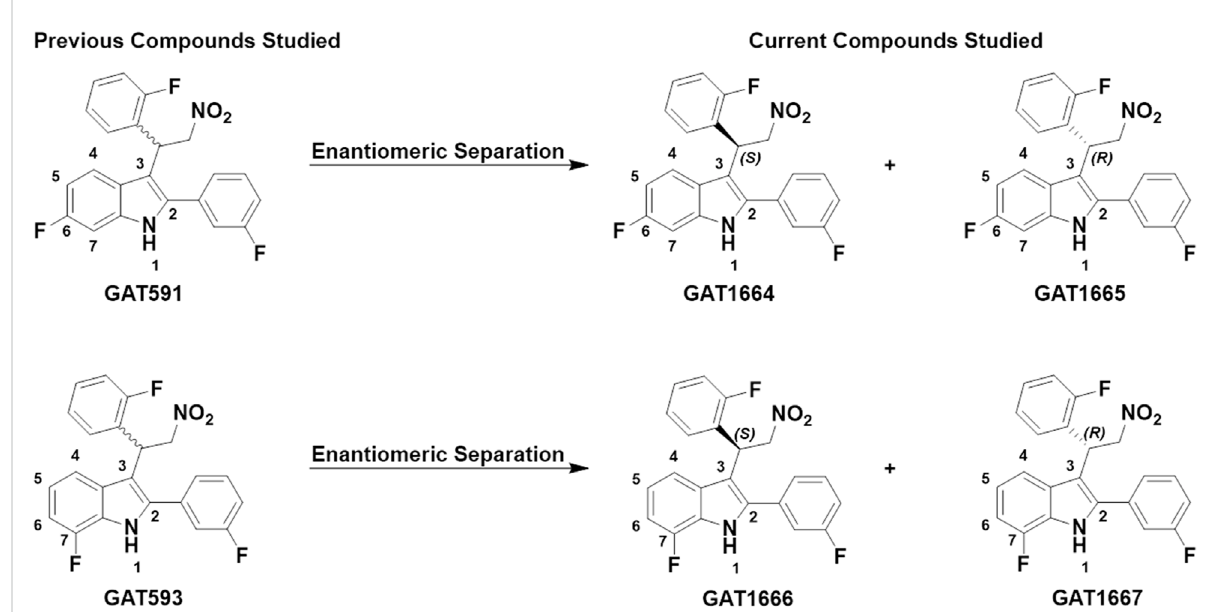
FIGURE 1 GAT591 previously studied was separated out into its respective enantiomers (GAT1664 and GAT1665) and GAT593 was separated out into its respective enantiomers (GAT1666 and GAT1667). The difference between GAT1664 and GAT1665 vs. GAT1666 and GAT1667 is the position of the fl uorine in the indole